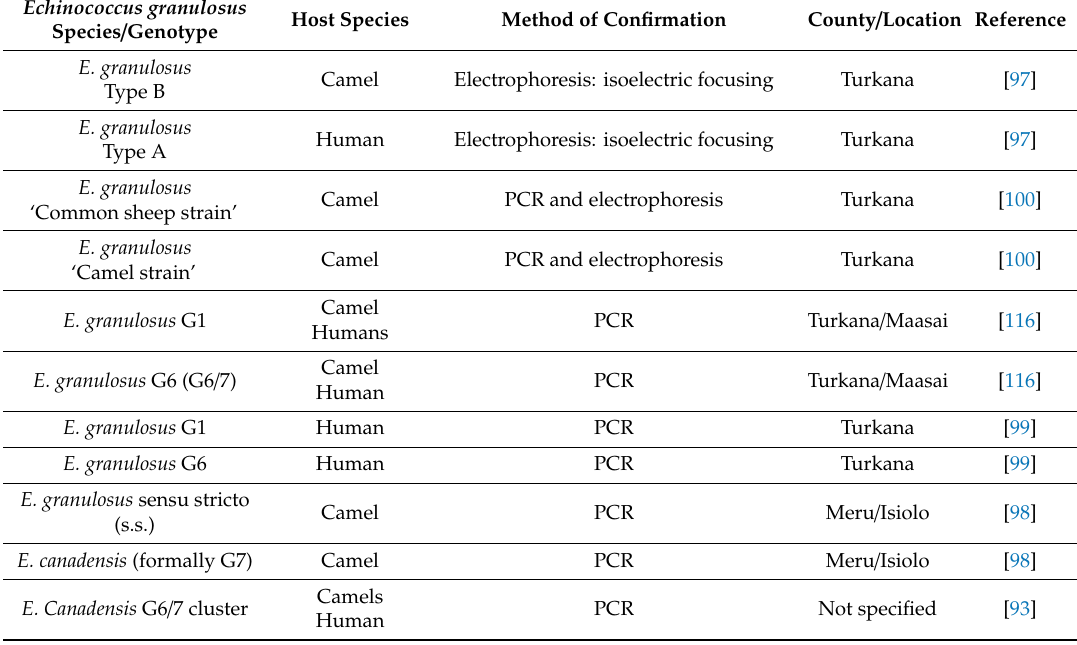
Table 5. Echinococcus granulosus sensu lato characterised according to the nomenclature set out in each paper to describe strain, species and genotype, with host species and diagnostic method